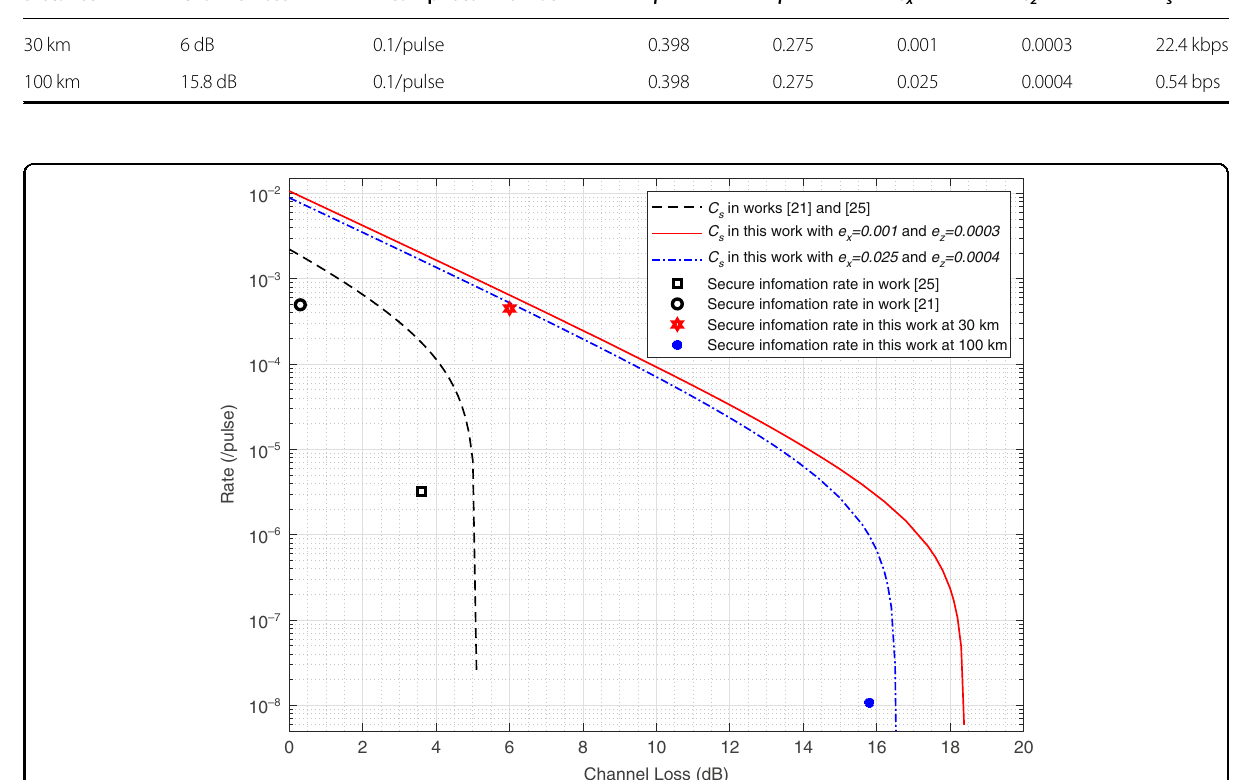
Fig. 3 Simulation with experimental parameters. Comparison of secrecy capacity and secure information rate between previous works and this